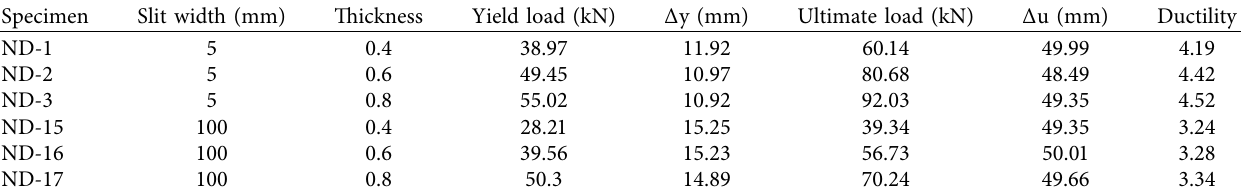
Table 7: Loads, displacement, and ductility of different thickness.